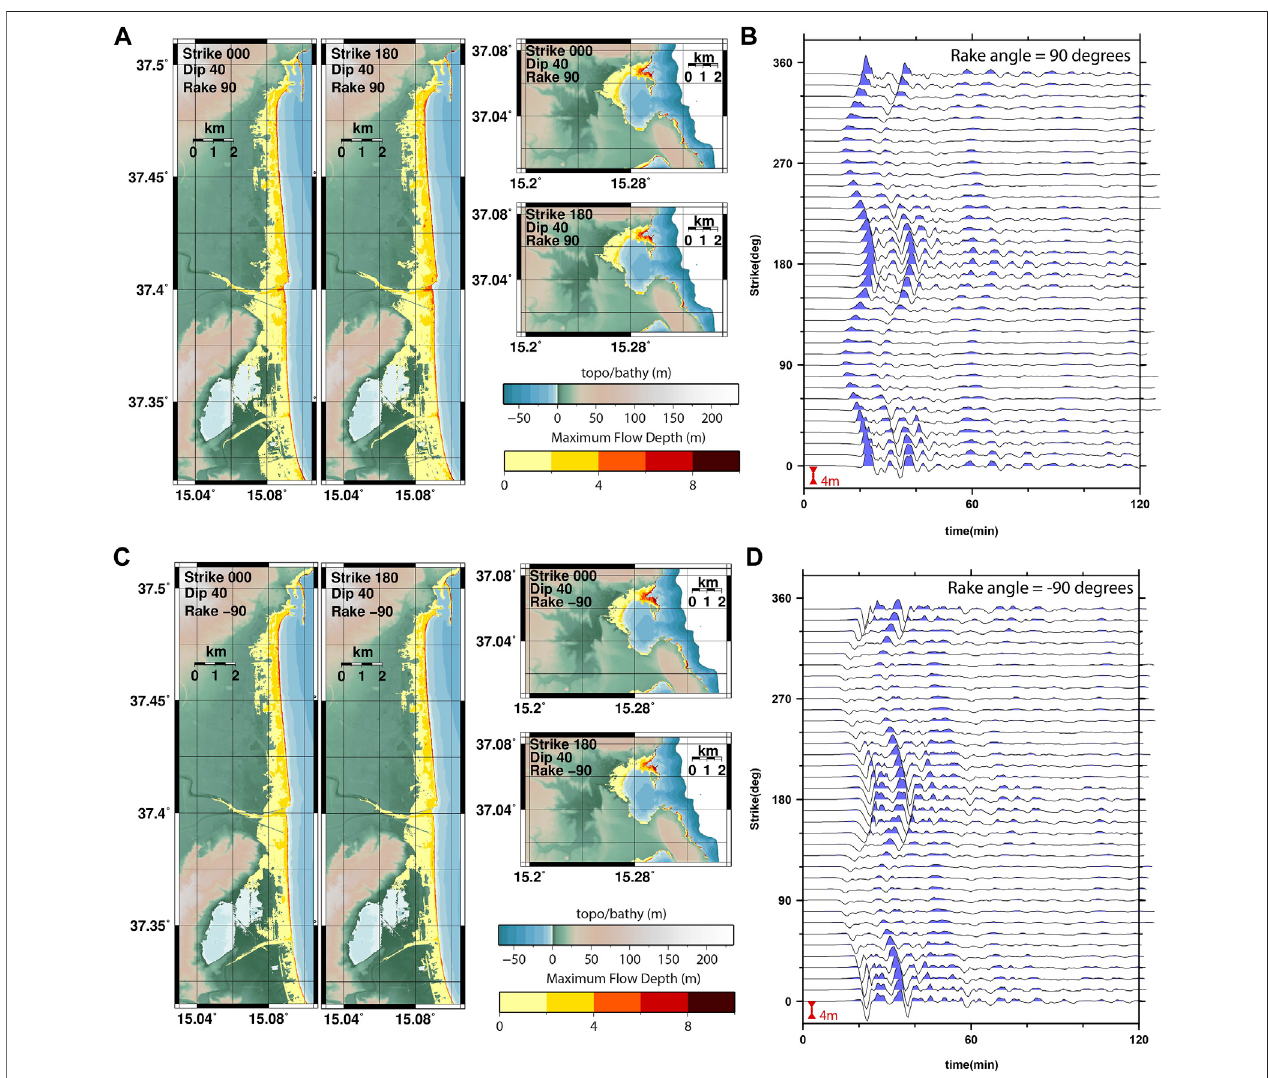
FIGURE 9 | Inundation maps for Catania and Siracusa for the relatively distant offshore earthquakes as indicated together with surface elevation time-series as simulated at the location 37.5368 o N, 15.1333 o E. Panels (A,B) display inundation maps and time-series for rake (cid:1) 90 o , panels (C,D) for rake (cid:1) − 90 o . The time-series are all for the dip (cid:1) 50 o scenarios. Vertical surface elevation scales and colour scales are identical for all panels.